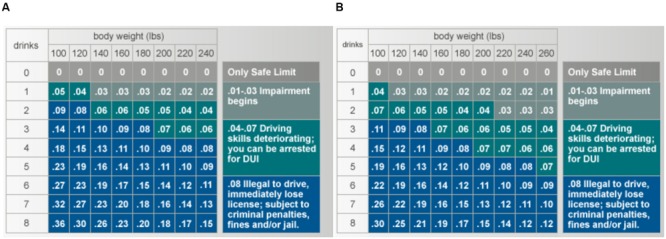
Relationship between Alcohol Consumption and BAC. (A) Represents the average blood alcohol content for women based on number of drinks (12 oz. beer, 5 oz. wine, 1.5 oz. hard alcohol) and body weight. (B) Represents men.